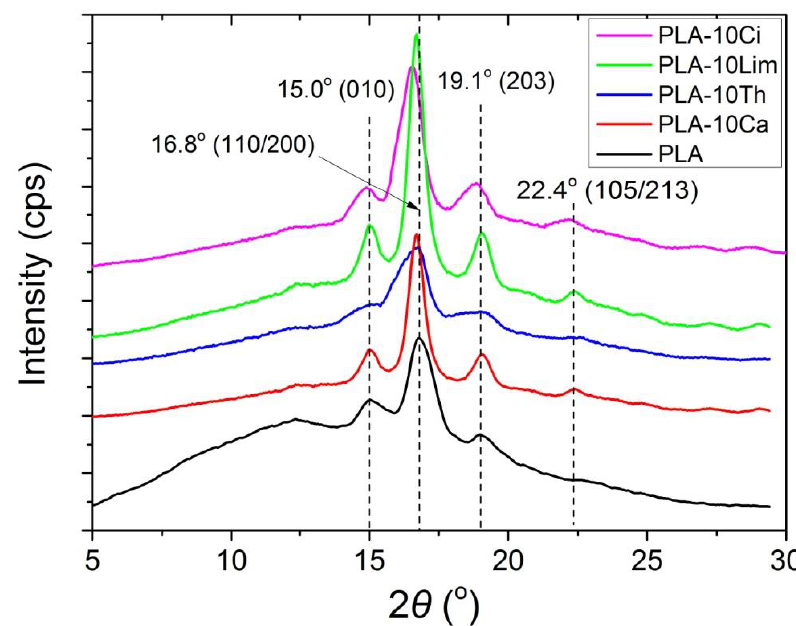
Figure 5. X-ray diffraction (XRD) patterns of the pure PLA and their composites with 10% thymol, carvacrol, limonene or cinnamaldehyde.